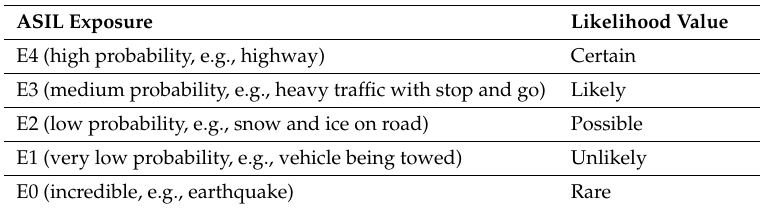
Table 11. Mapping our Qualitative Likelihood Scale for Vehicles to automotive safety integrity level (ASIL) Exposure Values.